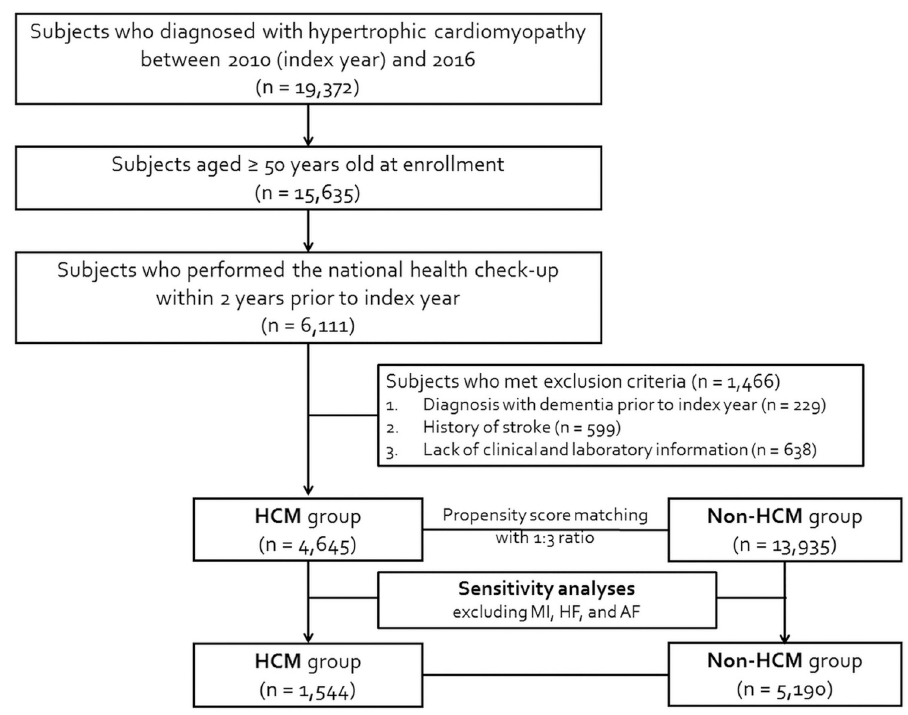
Fig 1. Schematic flow of the study population. AF, atrial fibrillation; HCM, hypertrophic cardiomyopathy; HF, heart failure; MI, myocardial infarction.